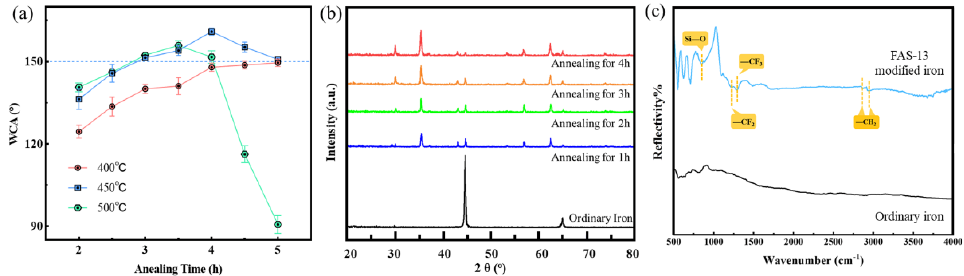
Figure 3. ( a ) Wettability contact angle (WCA) profiles of various samples annealed at 400, 450 and 500 °C for different times (2, 3, 4, and 5 h, respectively); ( b ) XRD patterns of iron samples treated at 450°C for different times (0, 1, 2, 3, and 4 h); ( c ) FTIR spectra of ordinary iron and superhydrophobic iron modified with FAS-13.